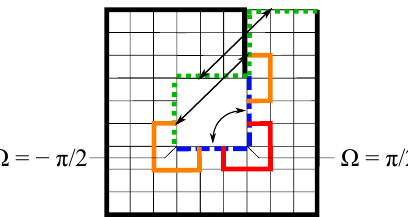
Figure B.2: A disclination dipole consisting of two disclinations with opposite Frank angle Ω = ± π/ 2 can be constructed in a fourfold rotation symmetric lattice by remov- ing a square from the sample and connecting the boundaries as indicated by the blue dashed and green dotted lines. The blue dashed lines indicate boundary conditions that involve a rotation by π/ 2. The green dotted lines indicate boundary conditions that do not involve any rotation. A path around the disclination with Frank angle Ω = π/ 2 ( Ω = − π/ 2) is indicated by the red (orange) bold line. For clarity, the sample boundary is highlighted by the black bold